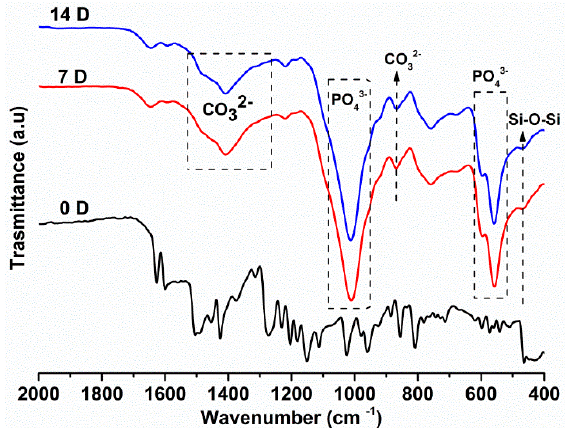
Figure 13. FTIR spectra of multilayer coatings before and after treatment in SBF for 7 and 14 days. The peaks of relevance are discussed in the text.